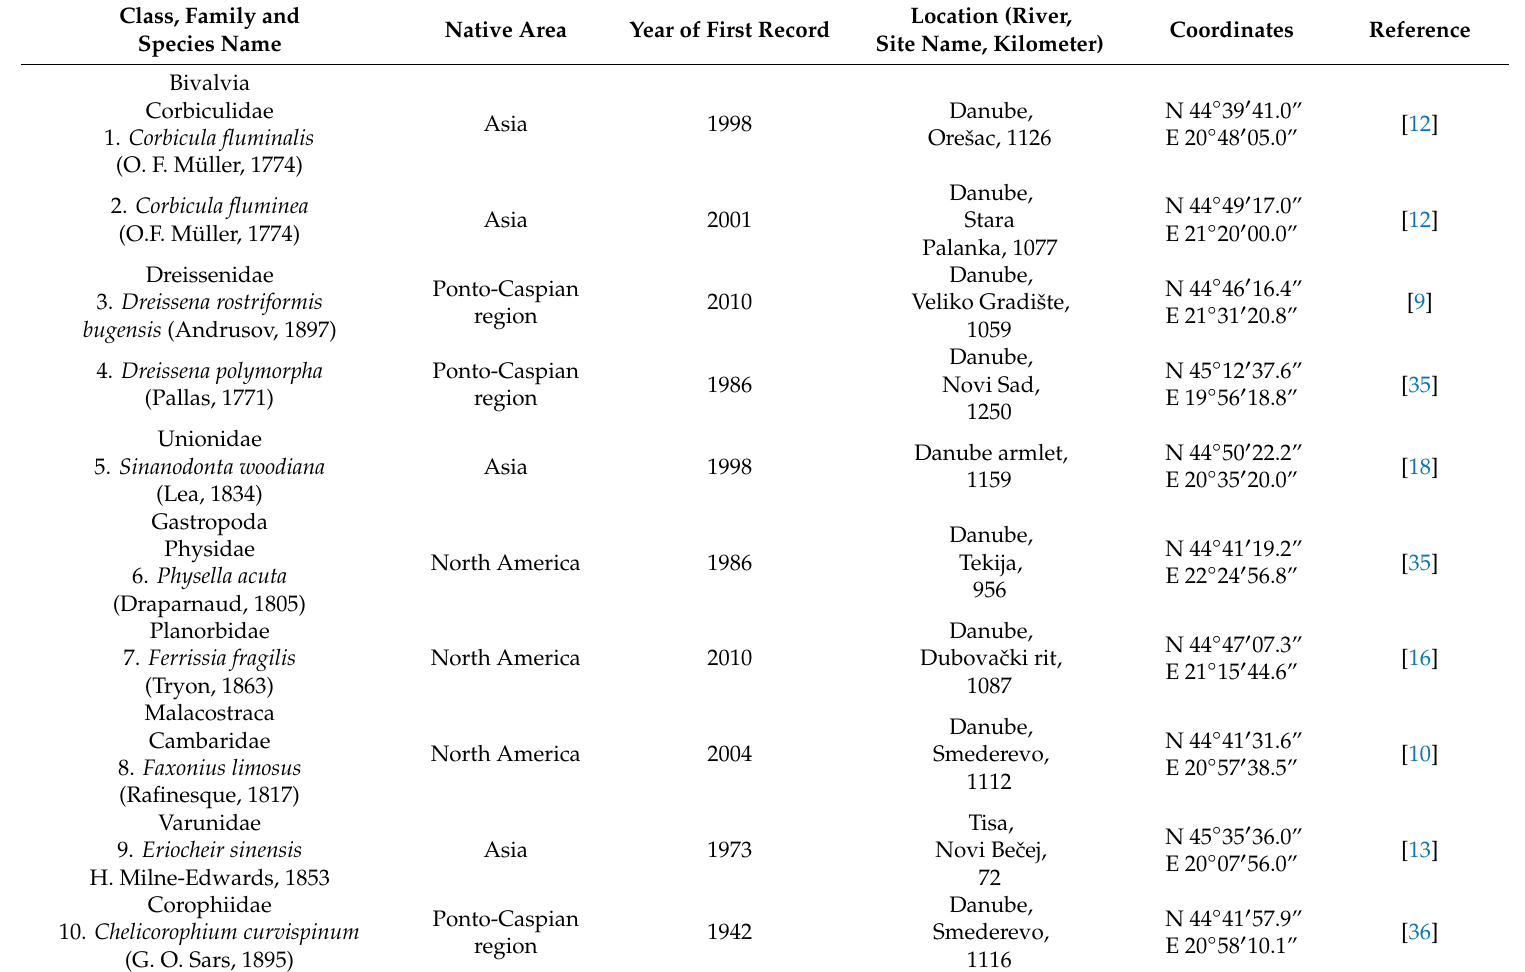
Table 1. Allochthonous macroinvertebrate species in watercourses of Serbia. (JDS 3—Joint Danube Survey 3). Class, Family